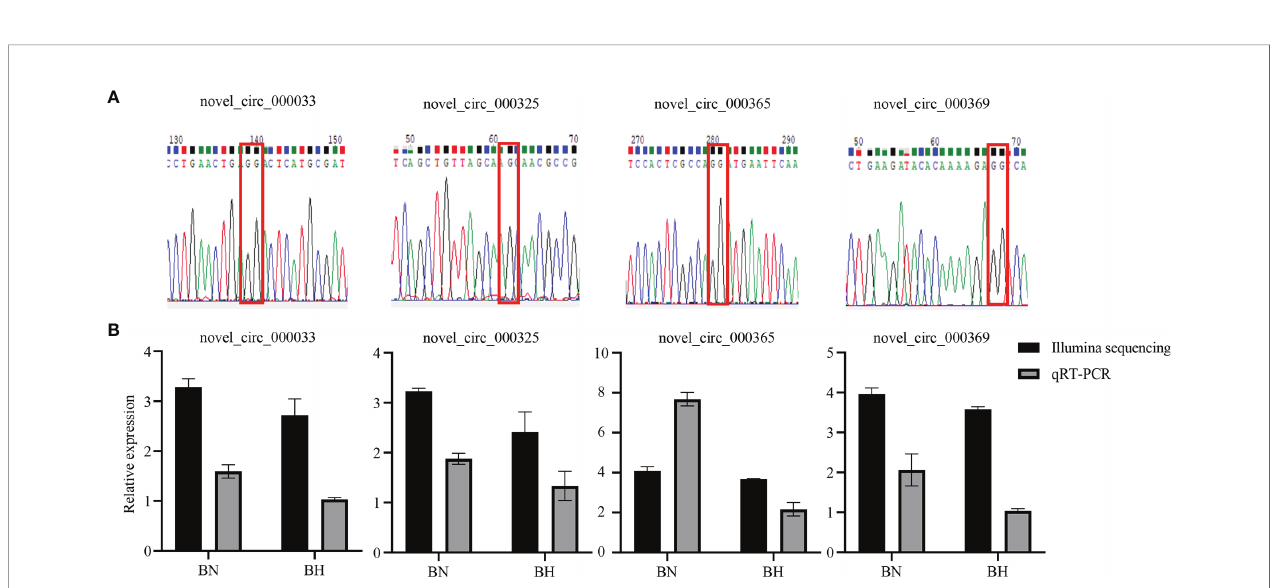
FIGURE 3 | Validation of circular RNAs (circRNAs) by Sanger sequencing and qRT-PCR. (A) Sanger sequencing for the head-to-tail back-splicing of circRNAs. The nucleotides highlighted by red boxes indicate the junction sites. (B) The qRT-PCR analysis results and data obtained from RNA sequencing (RNA-Seq) in blind-side normal (BN) and blind-side hypermelanotic (BH) groups.